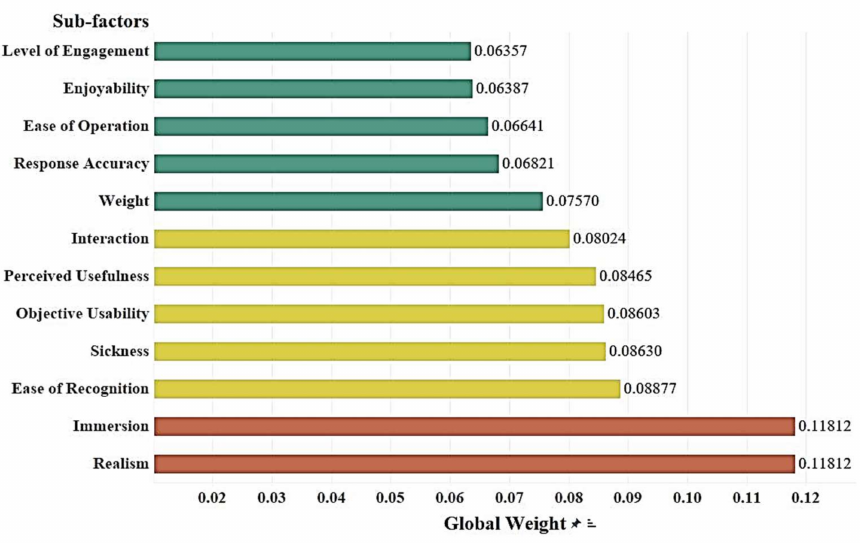
Figure 10. Global weights of